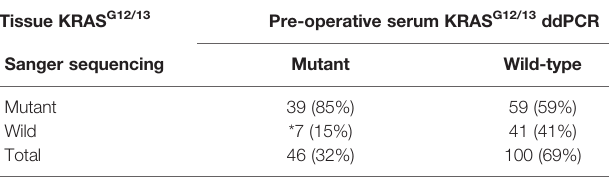
TABLE 1 | Comparison of pre-operative serum and tissue KRAS G12/13 detection in CRAC patients (n = 146). Tissue KRAS G12/13